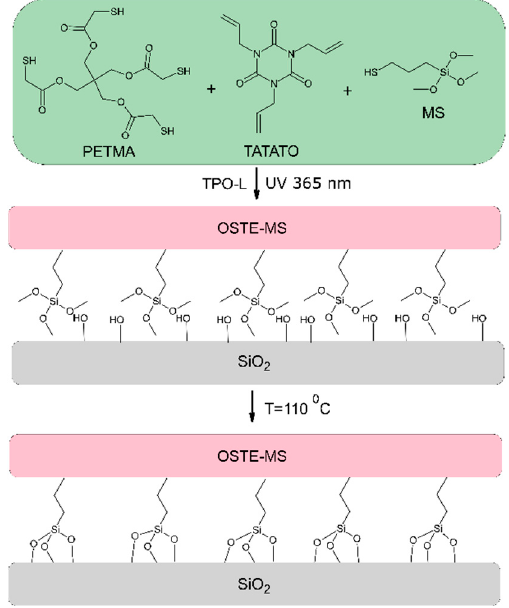
Figure 1 . Schematic illustration of the OSTE-MS polymer fabrication process and the crosslinking with the surface.